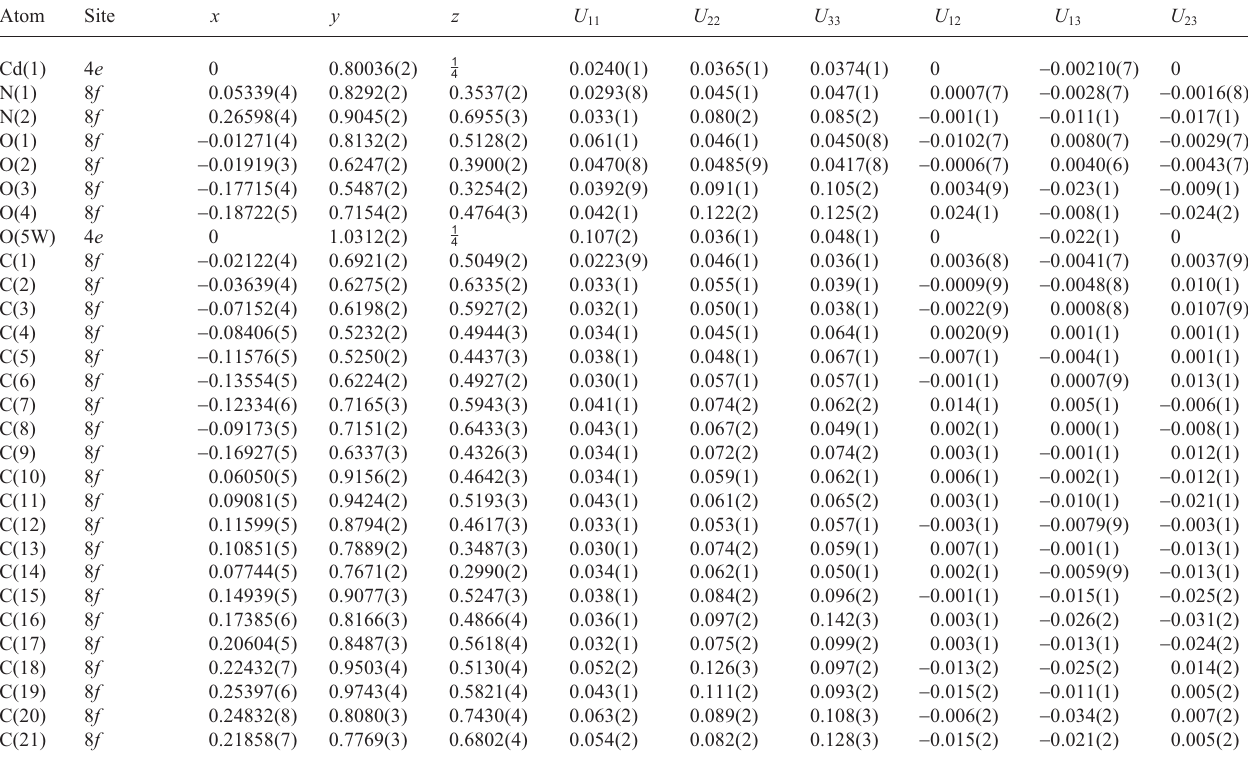
Table 3. Atomic coordinates and displacement parameters (in Å 2 )